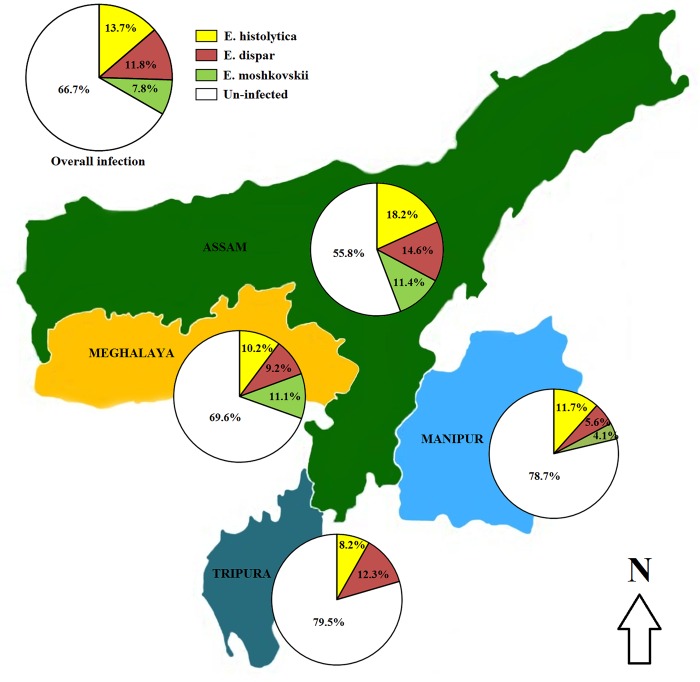
Prevalence of E. histolytica, E. dispar and E. moshkovskii stratified by four Northeast Indian states.